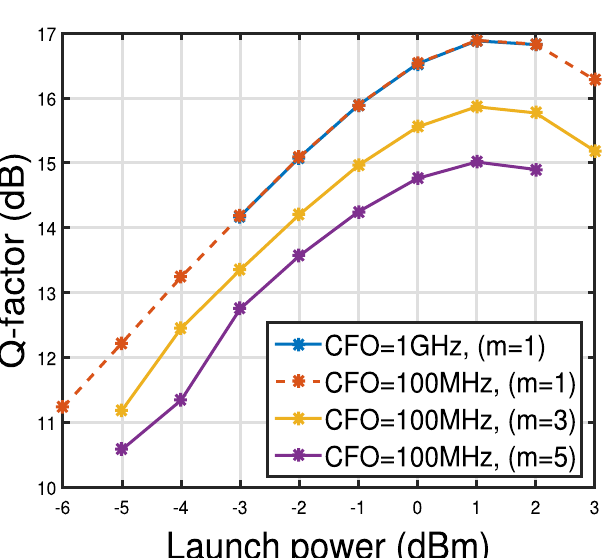
Figure 6. Constellation diagrams of the received signal on 12 spans, �ν 100 kHz. ( a ) PDM-16-QAM before 2 state MKF, ( b ) PDM-16-QAM after 2 state 0 dBm, N s = = 1 ( c ) m 5 , ( d ) m 10 . MKF for m = = =